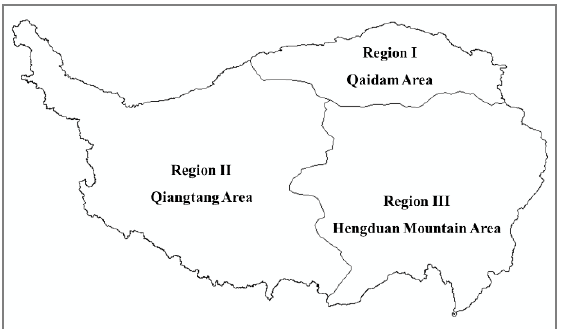
Figure 3 . The geographical division of three climatic regions